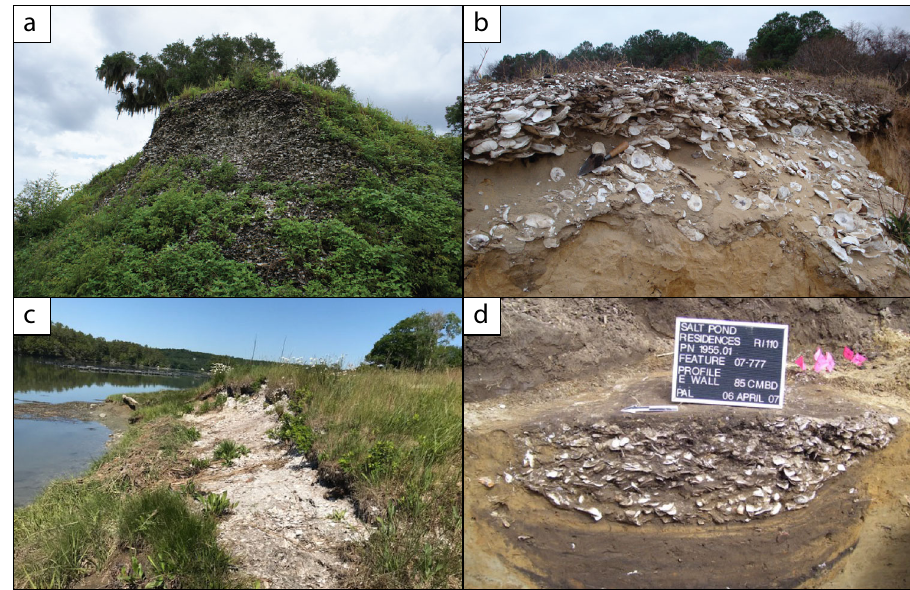
Fig. 4 Examples of archaeological sites, North American Atlantic and gulf coasts. a Mound A made almost entirely of oyster at the Crystal River site, Florida Gulf Coast, which is estimated to contain 20 – 30 million oysters which accumulated between 1330-800 years ago (Photo credit: Victor Thompson). b A small Late Holocene site at Fishing Bay, Maryland, perhaps a camp or processing site, with some 2 million oysters which accumulated from 1250 – 950 years ago (Photo credit: Torben Rick). c Oyster shell midden dated to 2200 – 1300 years ago at Site 26.15 on the Damariscotta Estuary, Maine (Photo credit: Bonnie Newsom). d Small pit feature with oysters and other food remains on the coast of Rhode Island dated to 1000 – 500 years ago (Late Woodland) (Photo credit: Kevin McBride).